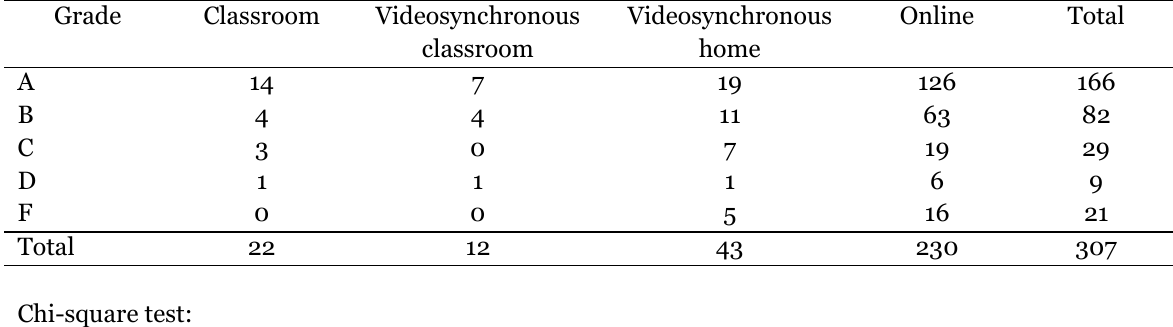
Chi-Square Analysis on Association Between Grade Distribution and Learning Mode Grade